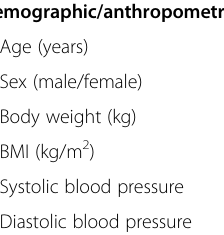
Kawauchi village (with